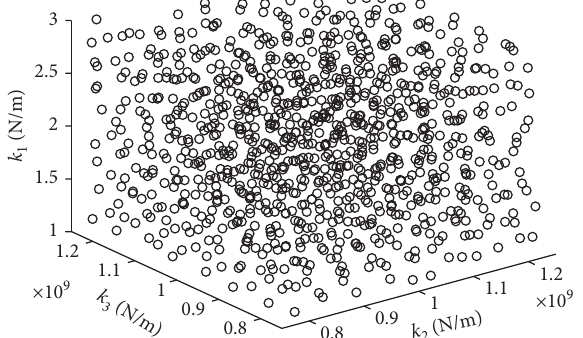
Figure 10: Optimal Latin hypercube sampling for k (sample size: